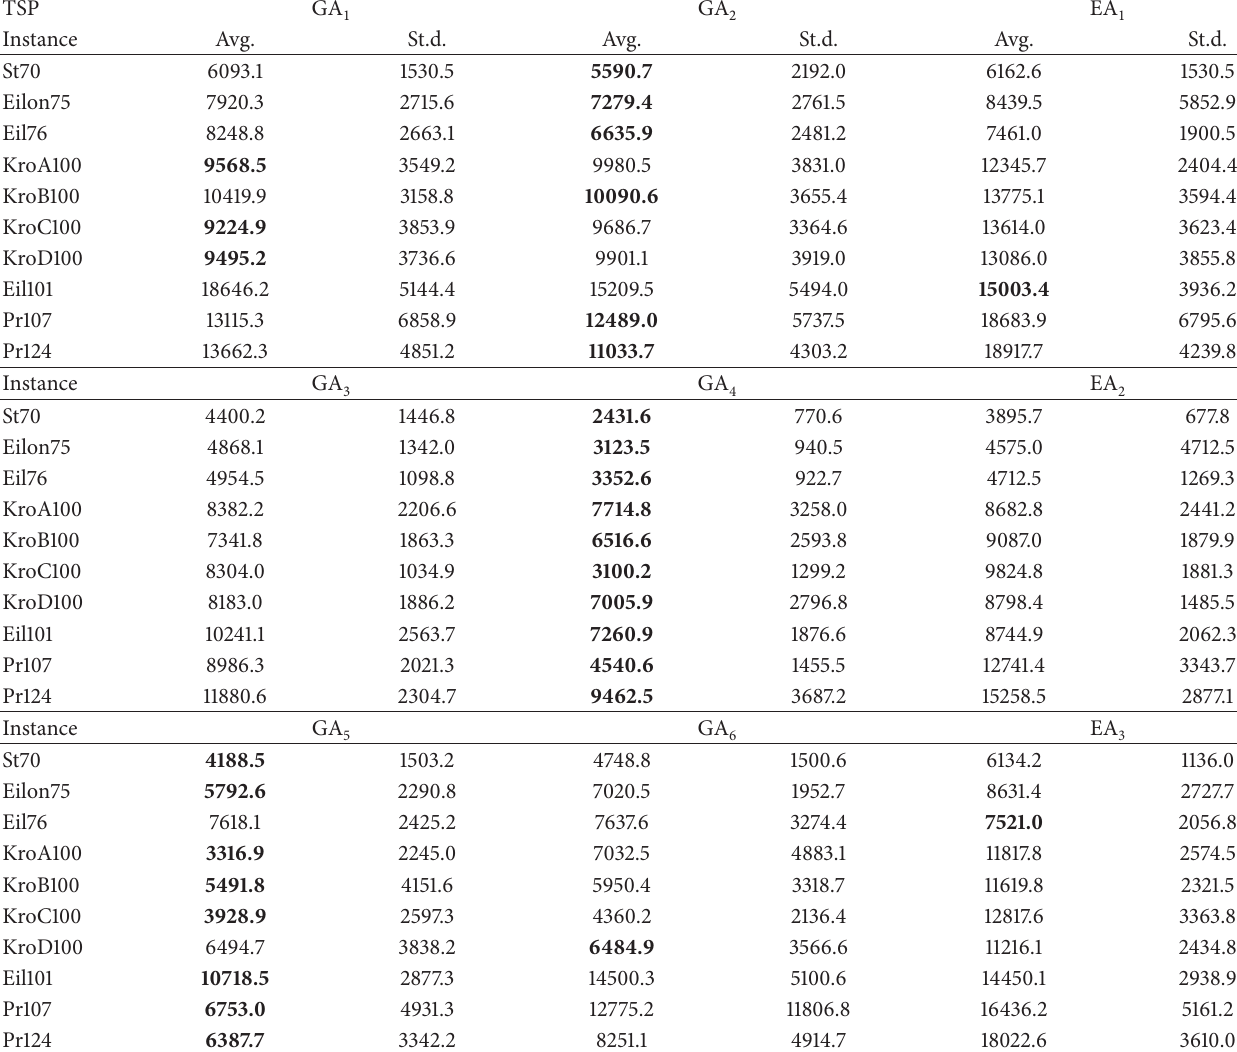
Table 3: Convergence behaviour of the nine techniques applied to the